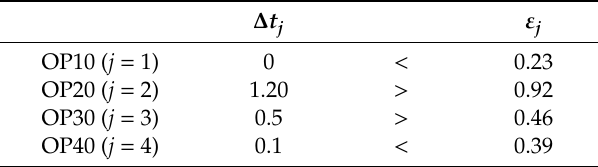
Table 2. Evaluation of time di ff erences for